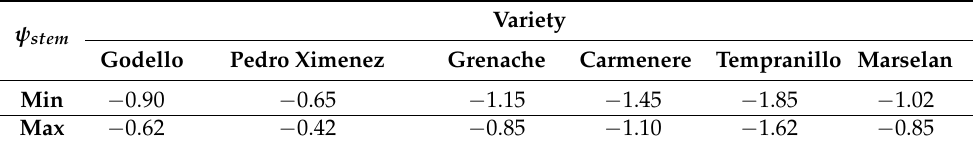
Table 5. Stem water potential ( ψ stem ) ranges per variety.